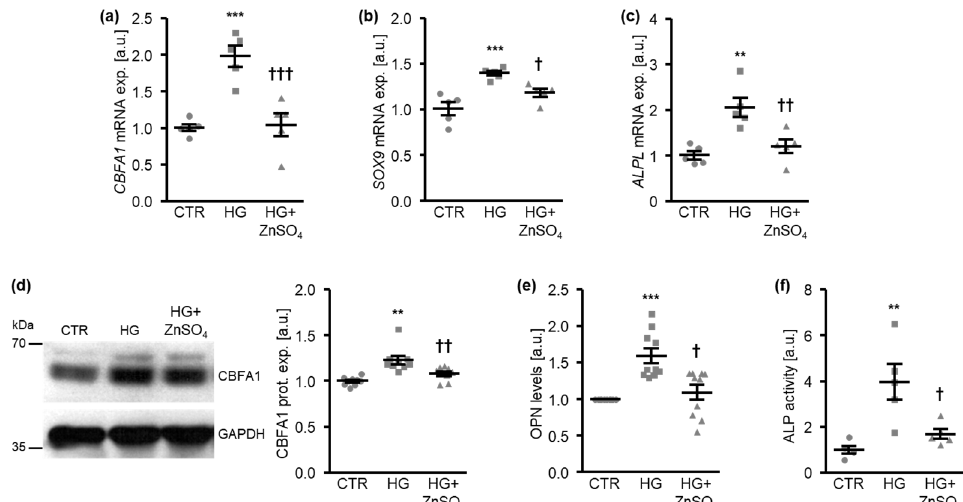
Figure 2. Zinc sulfate suppresses osteo-/chondrogenic marker expression promoted by high glucose levels in HAoSMCs. ( a – c ). Relative mRNA expression of CBFA1 ( a ), SOX9 ( b ), and ALPL ( c ) ( n = 5; arbitrary units, a.u.) in HAoSMCs treated for 24 h with control (CTR) or high glucose levels (HG) in the absence and presence of ZnSO 4 . ( d ). Representative Western blots and normalized CBFA1 protein expression ( n = 9; a.u.) in HAoSMCs treated for 24 h with control (CTR) or high glucose levels (HG) in the absence and presence of ZnSO 4 . ( e ). Normalized OPN levels ( n = 10; a.u.) in conditioned medium from HAoSMCs treated for 7 days with control (CTR) or high glucose levels (HG) in the absence and presence of ZnSO 4 . ( f ). Normalized ALP activity ( n = 5; a.u.) in HAoSMCs treated for 7 days with control (CTR) or high glucose levels (HG) in the absence and presence of ZnSO 4 . ** ( p < 0.01), *** ( p < 0.001) significant difference versus control group; † ( p < 0.05), †† ( p < 0.01), ††† ( p < 0.001) significant difference versus the HG-treated group.